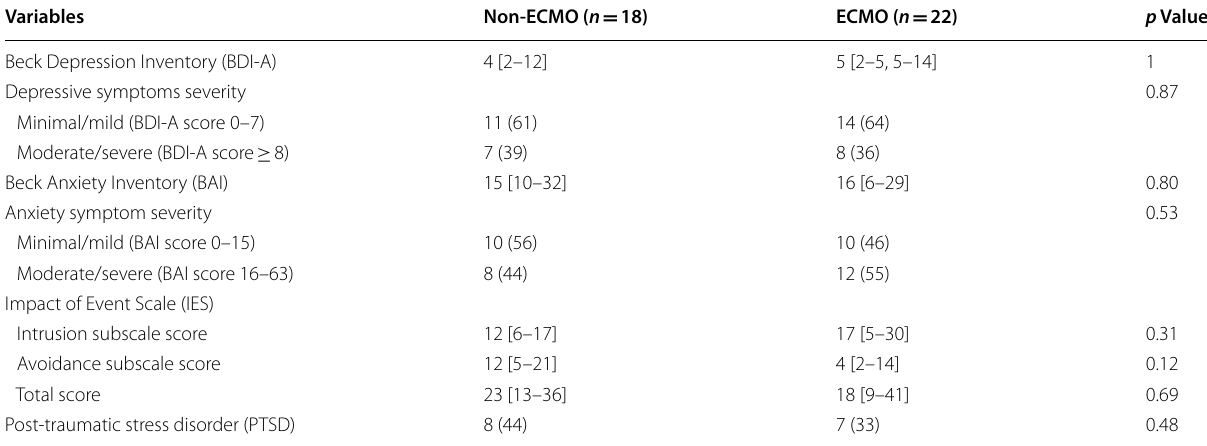
Table 3 Neuropsychological tests